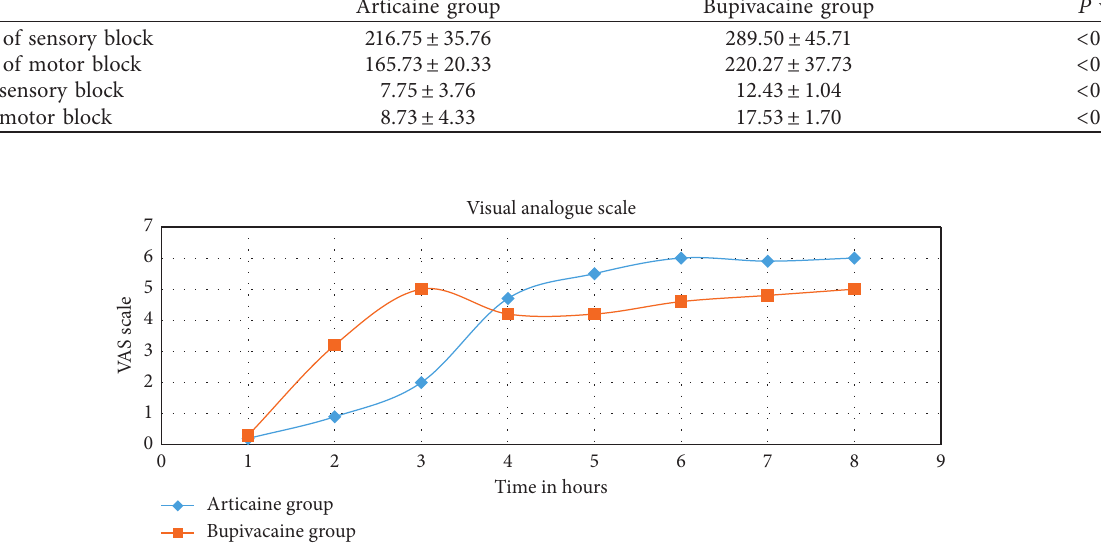
Figure 5: Visual analogue scale with low record in early hours and higher record postoperatively in the articaine Table 3: Visual analogue scale and patient satisfaction.